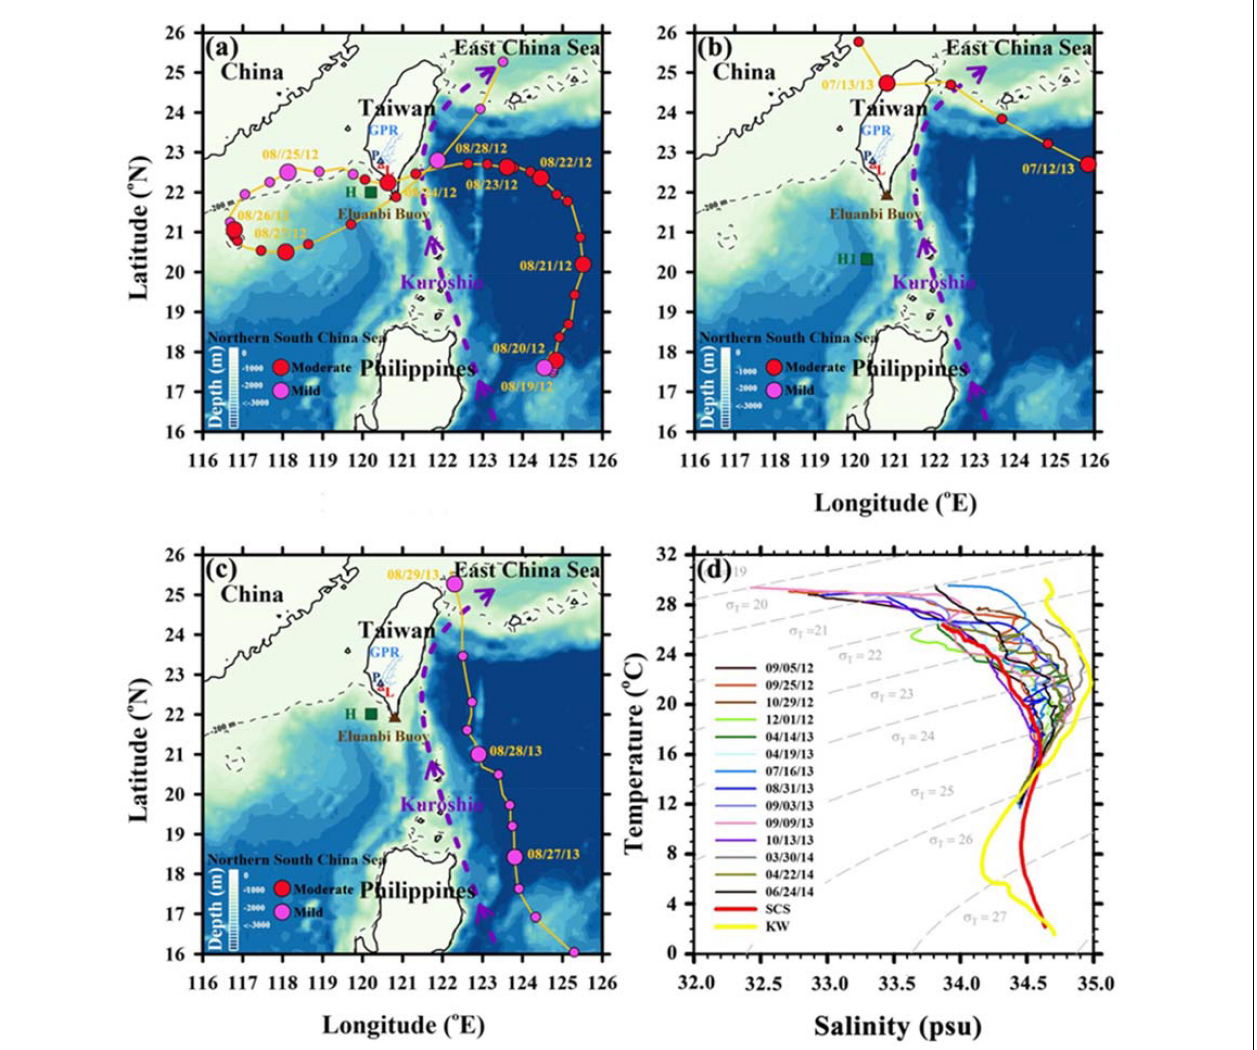
FIGURE 1 | The maps show the tracks of typhoon Tembin (a) , Soulik (b) , and Kongrey (c) . The 14 temperature-salinity profiles (d) are for the upper 300 m of the water column at station H (13 sampling events) or H1 (1 sampling event, i.e., typhoon Soulik ) between September 2012 and June 2014. For each typhoon, tracking (light yellow line) was initiated at 06:00 LMT on the start date (larger circle symbol) and then plotted at 6-h intervals (smaller circle symbol) using red or pink solid circles depending on typhoon intensity at the time. The dash purple line represents Kuroshio Current. The abbreviations GPR, P and L over southern Taiwan stand for Gaoping River, Pingtung rain gauge, and Liling river discharge station, respectively.